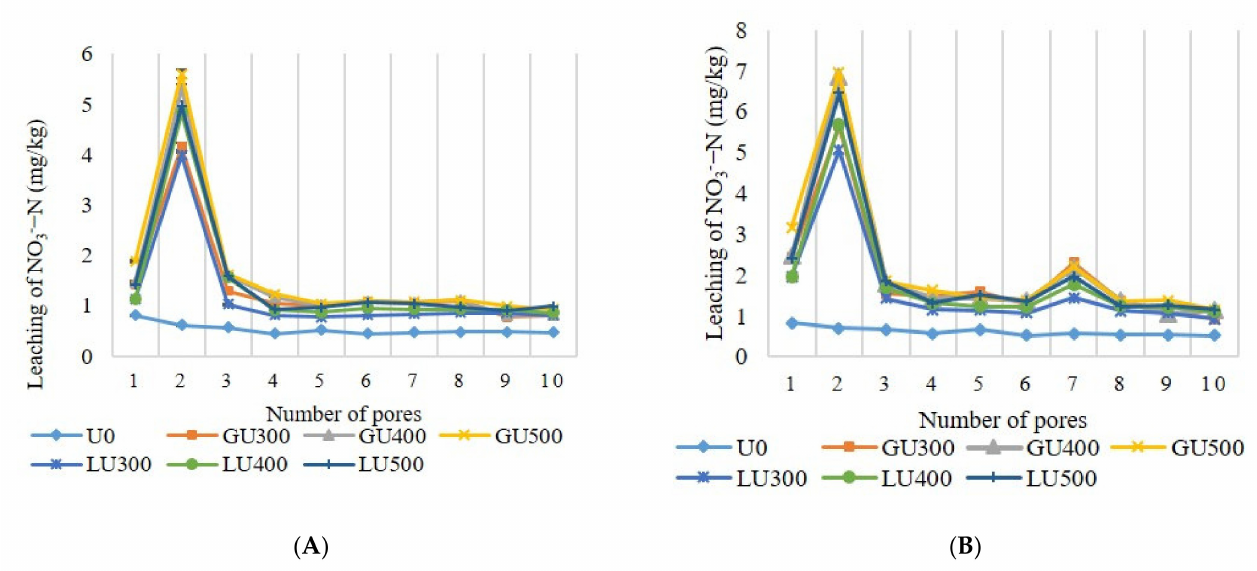
Figure 5. Leaching of NO 3– -N (mg/kg) from Bungor ( A ) and Selangor ( B ) soils treated with different rate of LU and GU fertilizers in 10 pore volumes. Vertical bars on the graphs show the standard